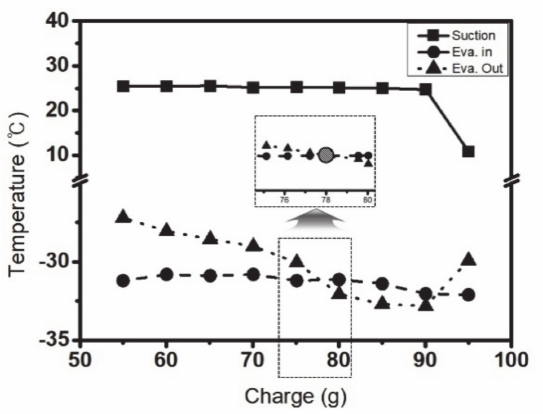
Figure 3. Results of the optimal refrigerant charging experiments.